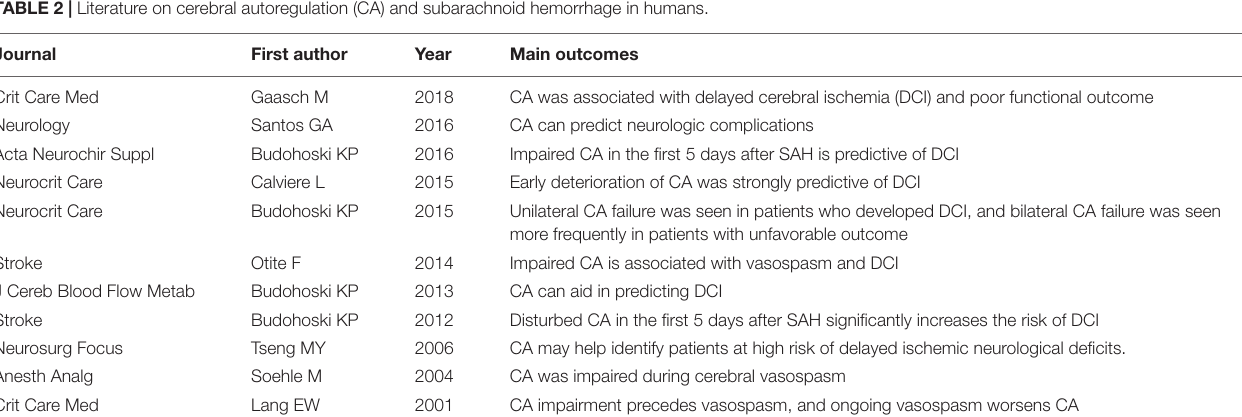
TABLE 2 | Literature on cerebral autoregulation (CA) and subarachnoid hemorrhage in